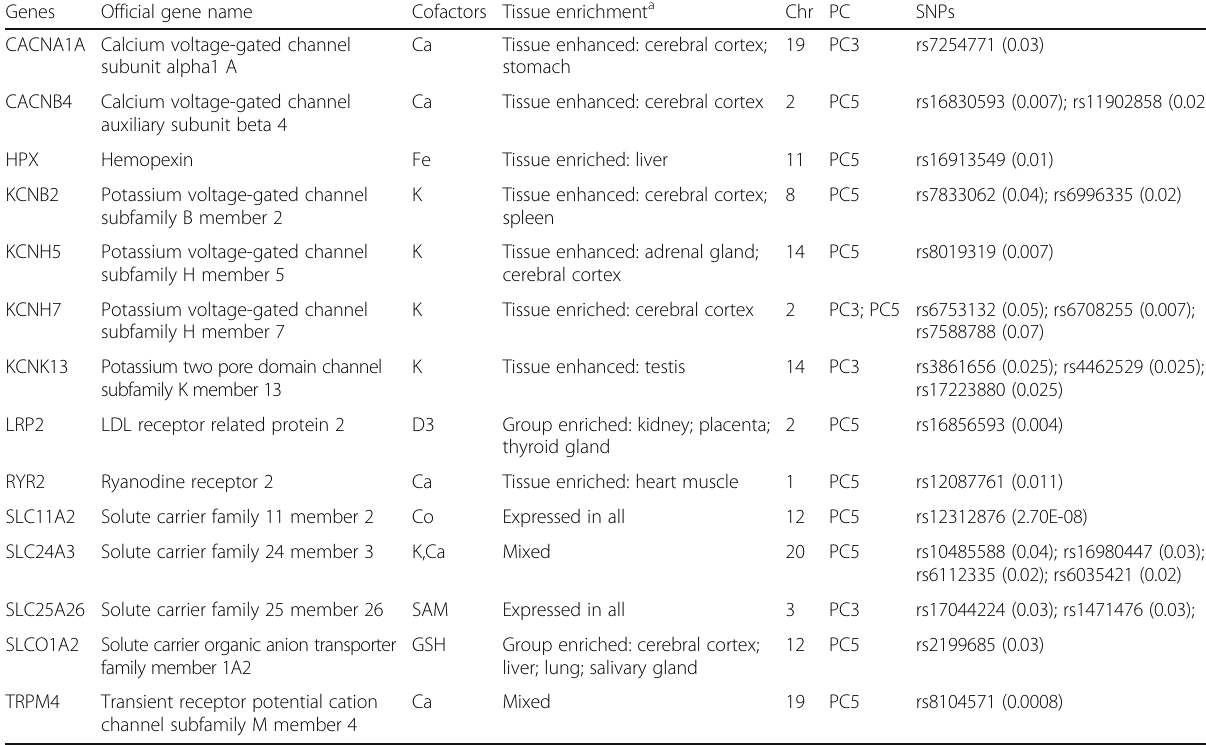
Table 1 Positively selected SNPs within cofactor transporter genes